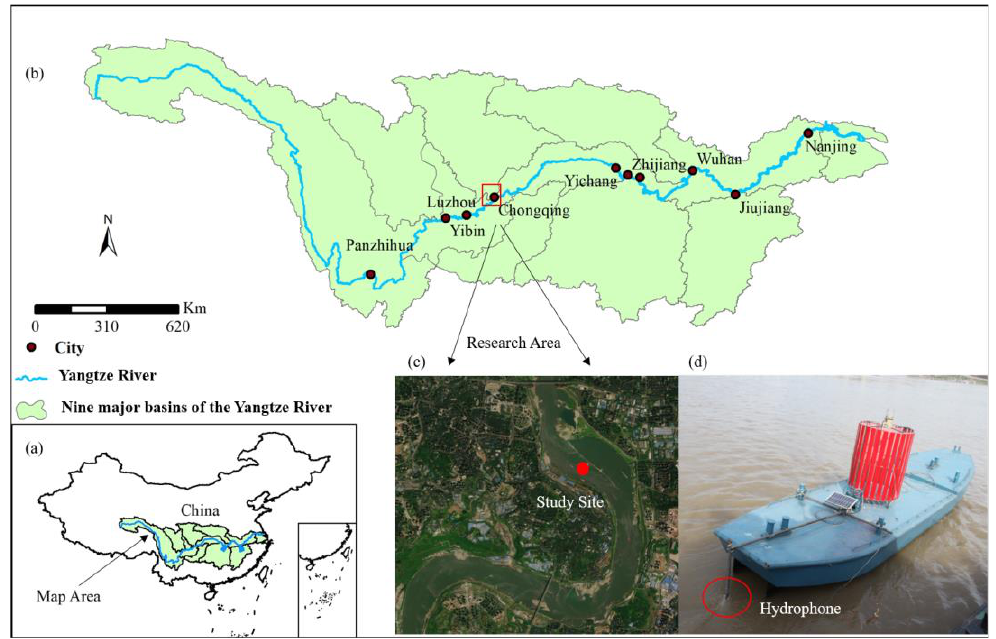
Figure 1. ( a ) Map of the study region in the Yangtze River in China; ( b ) Zoom on the details of the Yangtze River; ( c ) Photo of study reach and sketch of the sampling site (red dot); ( d ) Photo of installation of a hydrophone in the river (red circle).